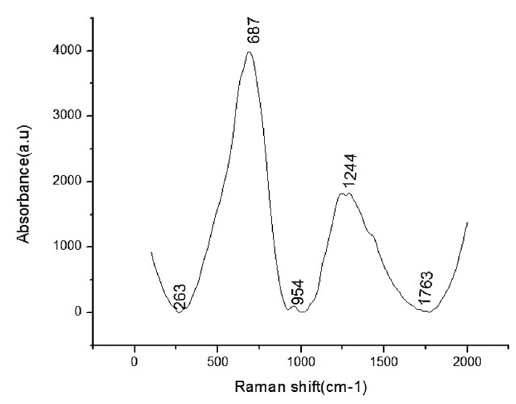
O (x=10 % and x 1 = 0.5 %) 2 5